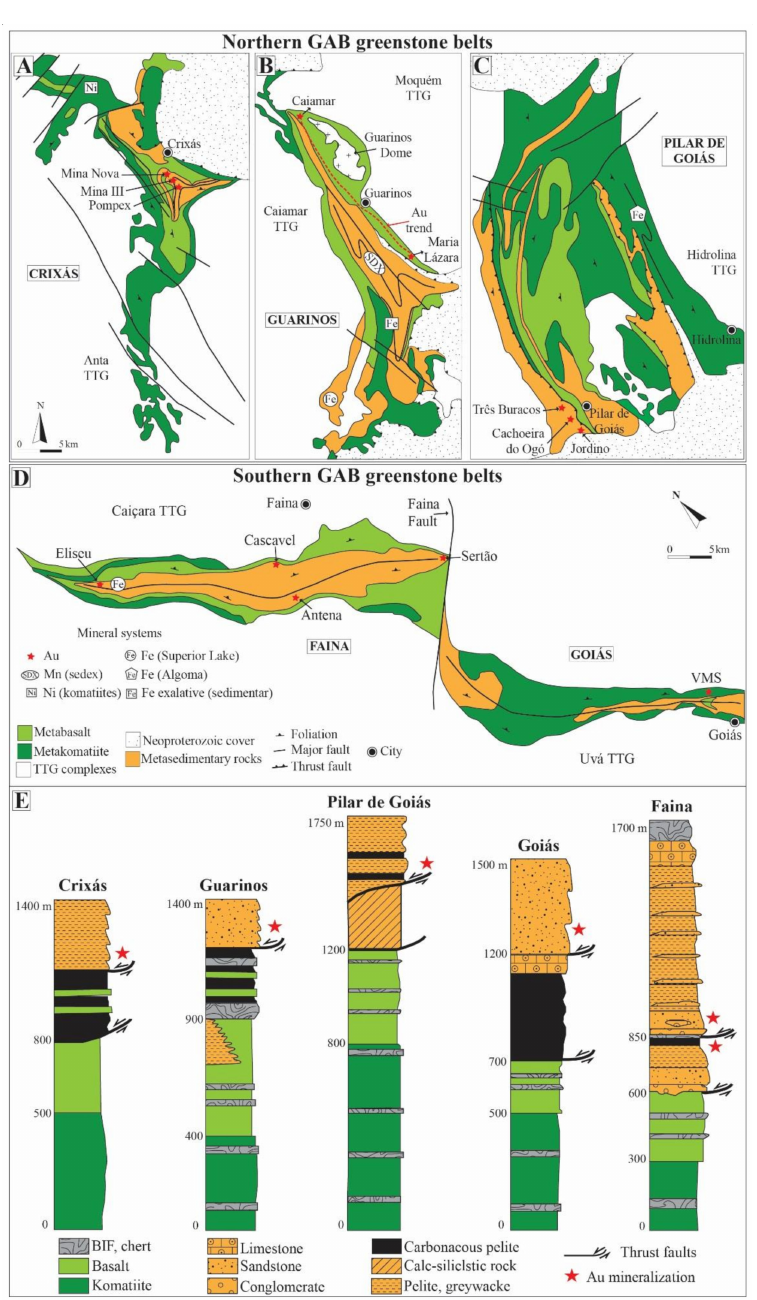
Figure 3. Geology of northern ( A – C ) and southern ( D ) greenstone belts from the Goi á s Archean Block (GAB), with corresponding stratigraphy ( E